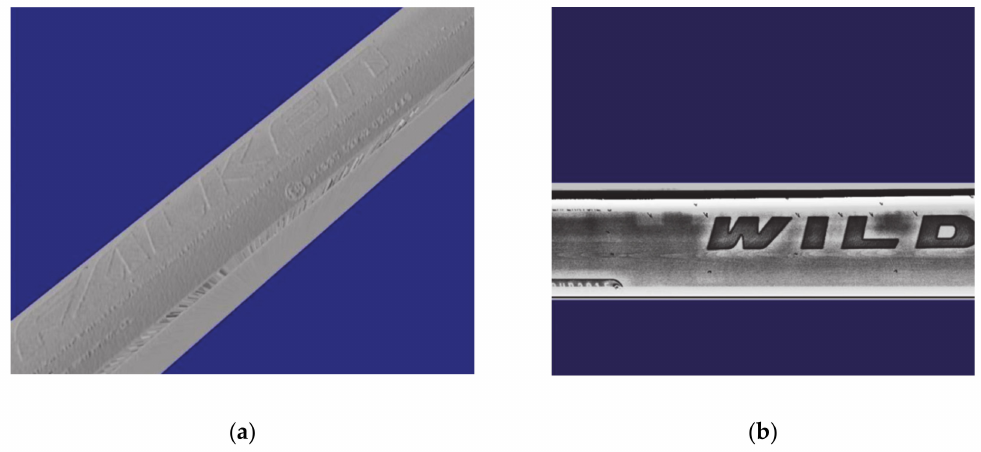
Figure 3. Pictures showing the ( a ) 3D reconstruction operated by the in-line quality control apparatus and ( b ) conversion to a 2D picture.